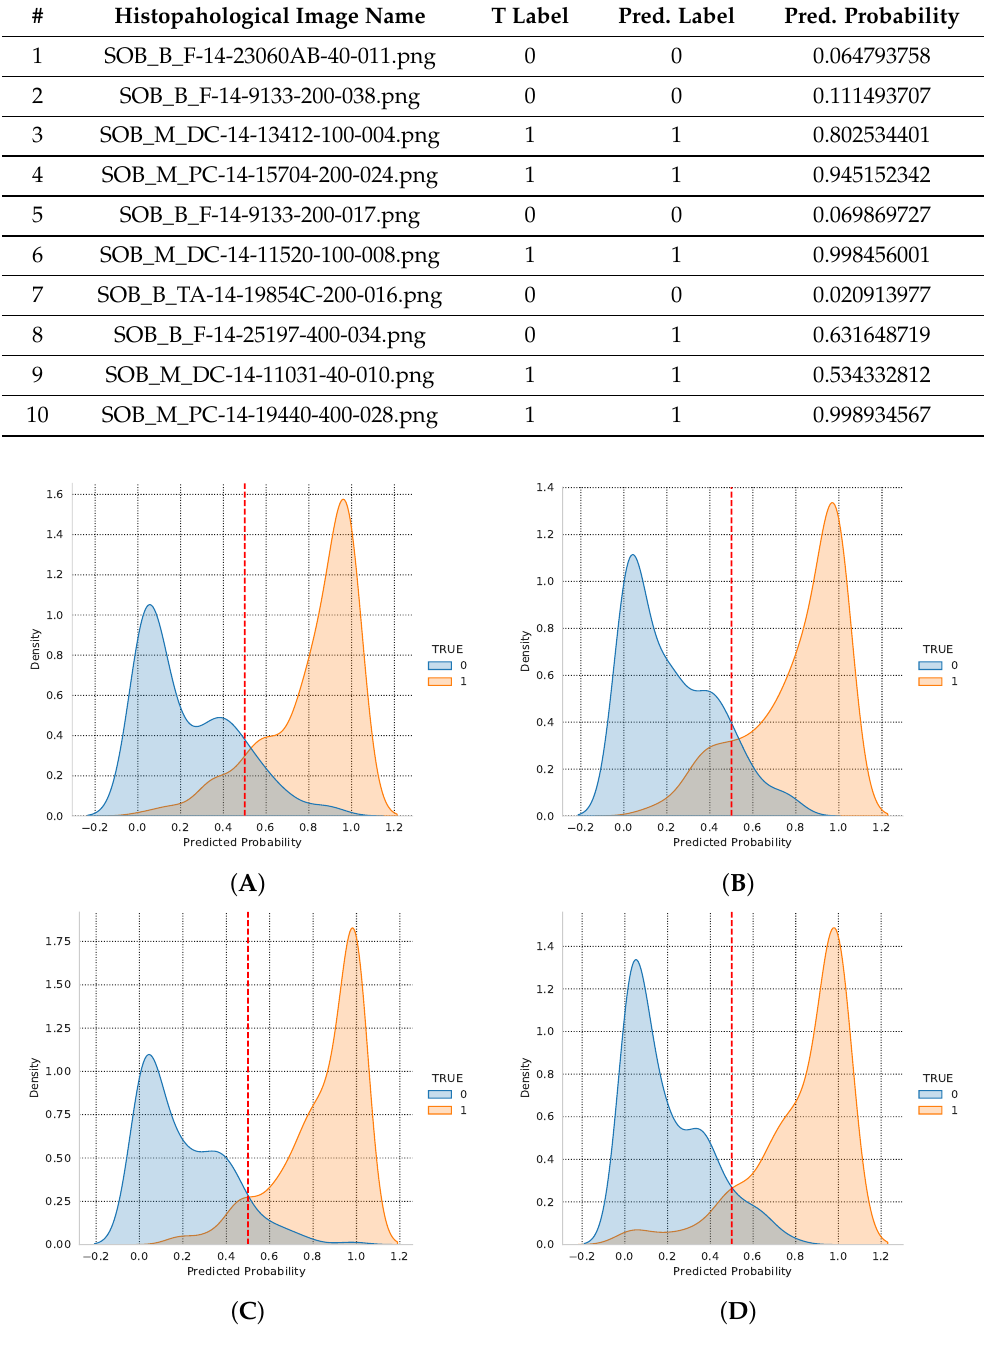
Figure 13. KDE of the four magnification factors. ( A ) 40x. ( B ) 100x. ( C ) 200x. ( D ) 400x. The gray area in the figures represents the area where there is a confusion, benign tumors are mistaken for malignant tumors or vice versa, resulting in inaccurate predictions. Those samples on the left of the border line are predicted non-cancerous cells while they are cancerous; those samples on the right of the border line are denoted as cancerous cells while they are not. Comparing the confusion areas of the different magnifcation factors (displayed in Figure 13A–D, the magnification factor of 200x has a minor area followed by a 400x magnification factor. It is evident that the prediction probability of cancerous cells is higher than those of non-cancerous cells; this is shown in all magnification factors